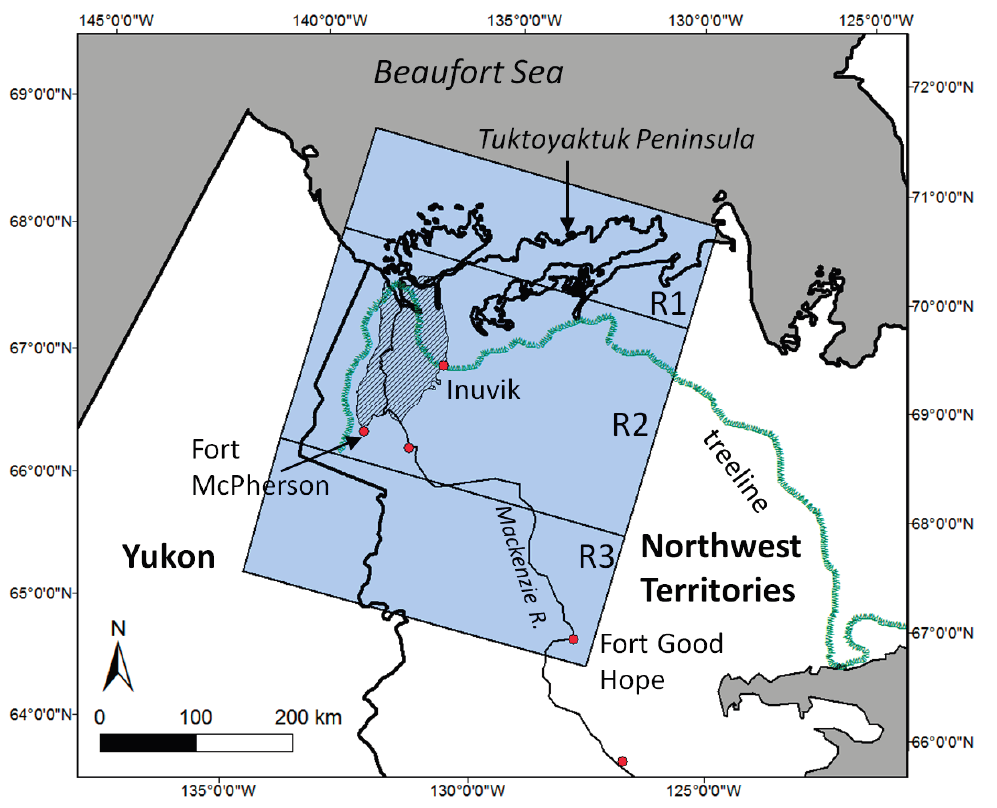
Figure 1. Study area covered by Landsat image stack from 1985 to 2011. Region 2 (R2) provided training data while Region 1 (R1) and Region 3 (R3) were used for